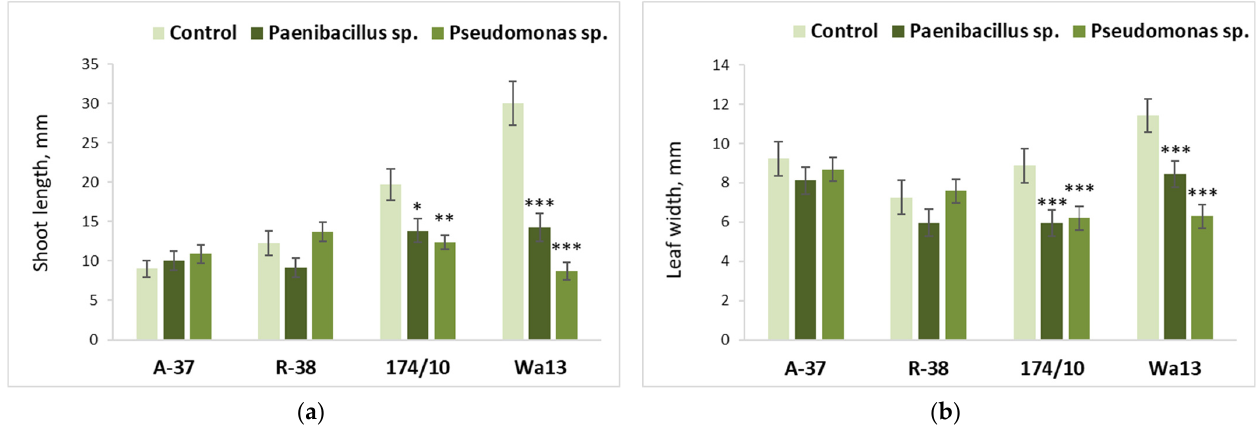
Figure 4. Average shoot length ( a ) and leaf width ( b ) of different Populus genotypes (A-37 and R-38, P. tremula ; 174/10 and Wa13, P. tremula × P. tremuloides ), inoculated with Paenibacillus sp. or Pseudomonas sp. bacteria. Statistically significant differences from the bacterium-free control variant are indicated (for each genotype separately): * p < 0.05; ** p < 0.01; *** p < 0.001.